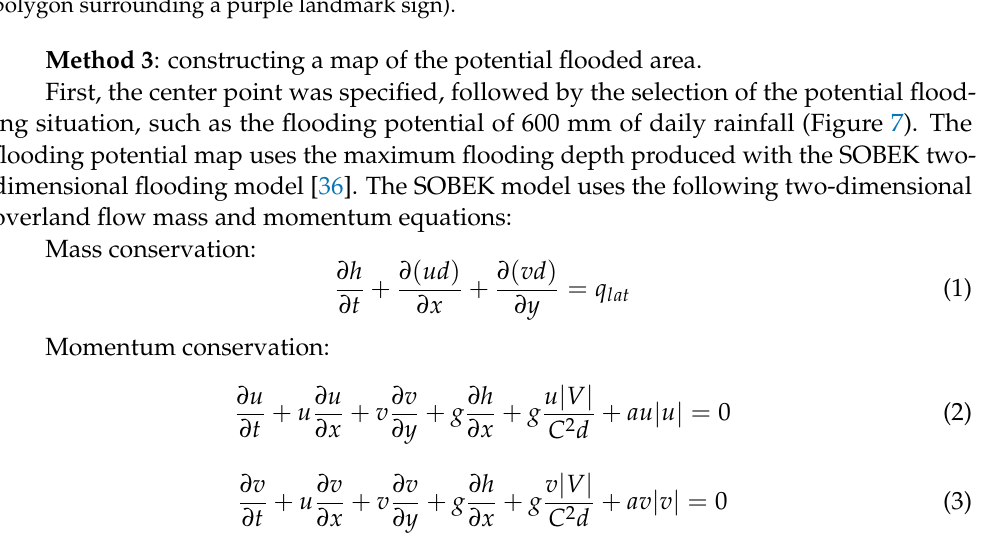
Figure 6. Method 2: Using historical flooding spots to calculate flooded areas (depicted as a pink polygon surrounding a purple landmark